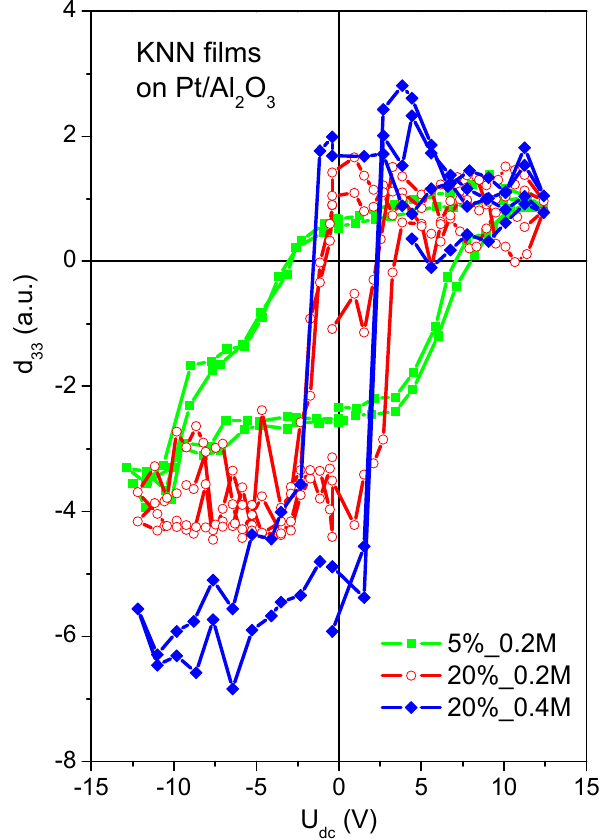
Figure 5. Local piezoresponse hysteresis loops of KNN thin films deposited on platinized Al 2 O 3 from solutions with 5% potassium excess and 0.2 M concentration (squares), with 20% alkali excess and 0.2 M concentration (circles), and with 20% alkali excess and 0.4 M concentration (rhombs).